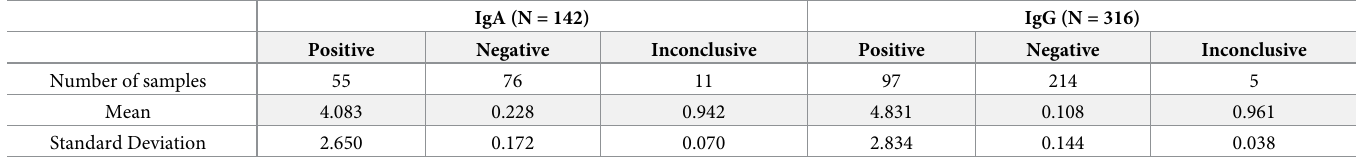
Table 1. Descriptive analysis of SerumCovid regarding IgA and